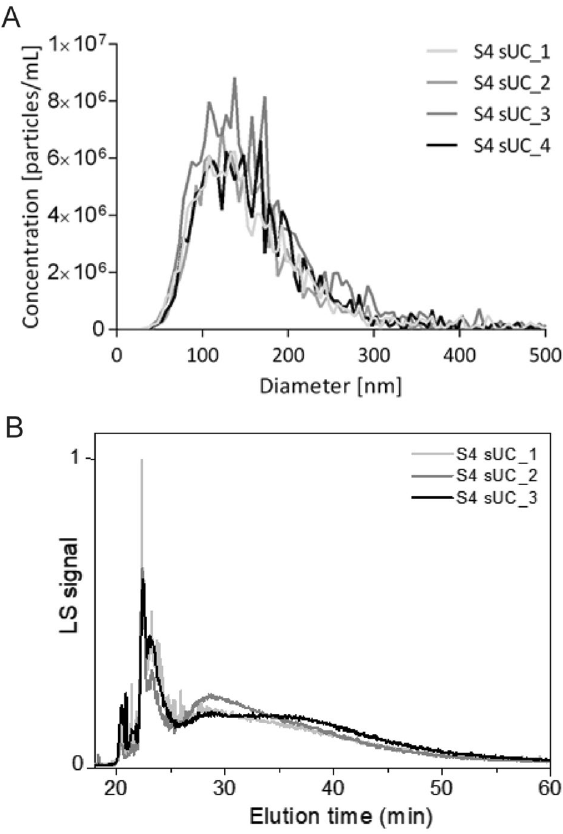
Figure 6. Repeatability of the sUC enrichment method linked to quantification with NTA and AF4-UV-MALS. ( A ) Quantification of nanoparticle size and concentration of four independently sUC-enriched aliquots of the same plasma sample by NTA. ( B ) Quantification of size and concertation of three independently sUC-enriched aliquots of the same plasma sample by AF4-UV-MALS. Representative fractogram. Representation of MALS and UV signals in relation to elution time in average of sample with and without enzymatic digestion after sUC. NTA nanoparticle tracking analysis, AF4-UV-MALS asymmetrical flow field-flow fractionation with ultraviolet and multi-angle light scattering detectors, sUC sucrose cushion